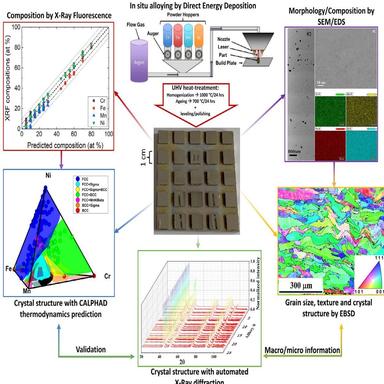
Schematic describing the high-throughput approach to materials processing using in situ alloying additive manufacturing (top), heat-treatment and polishing (center), and automated characterization: XRF (upper left), computational thermodynamics (lower left), X-Ray diffraction (bottom), EBSD on selected samples (lower right) and SEM/EDS (upper right).